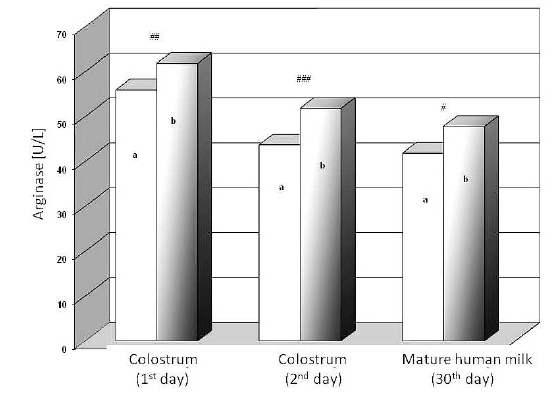
colostrum and mature human milk (a - without folic acid; b - with folic acid); ### p < 0.001 in comparison with colostrum and milk samples without added folic acid